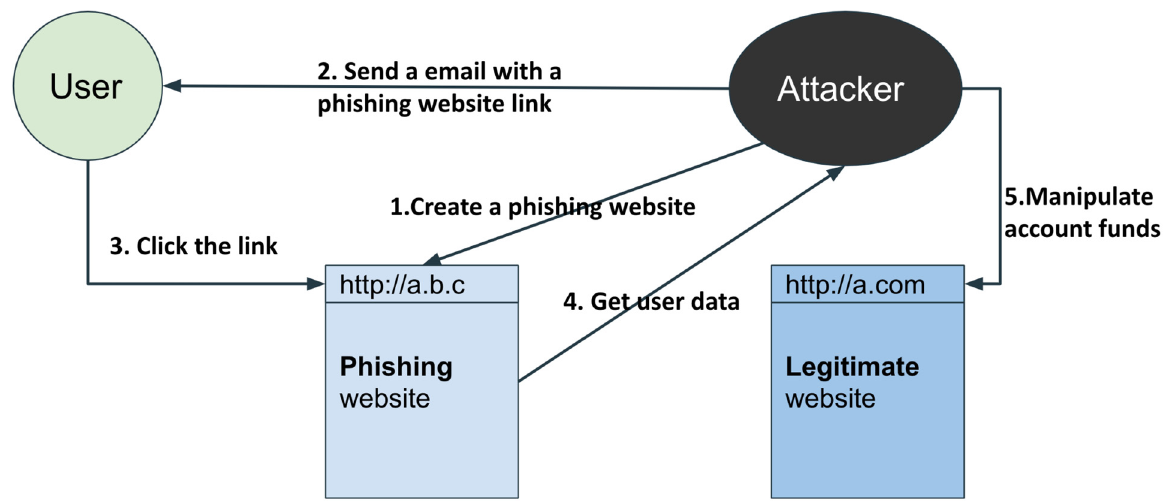
Figure 1. Phishing life cycle.